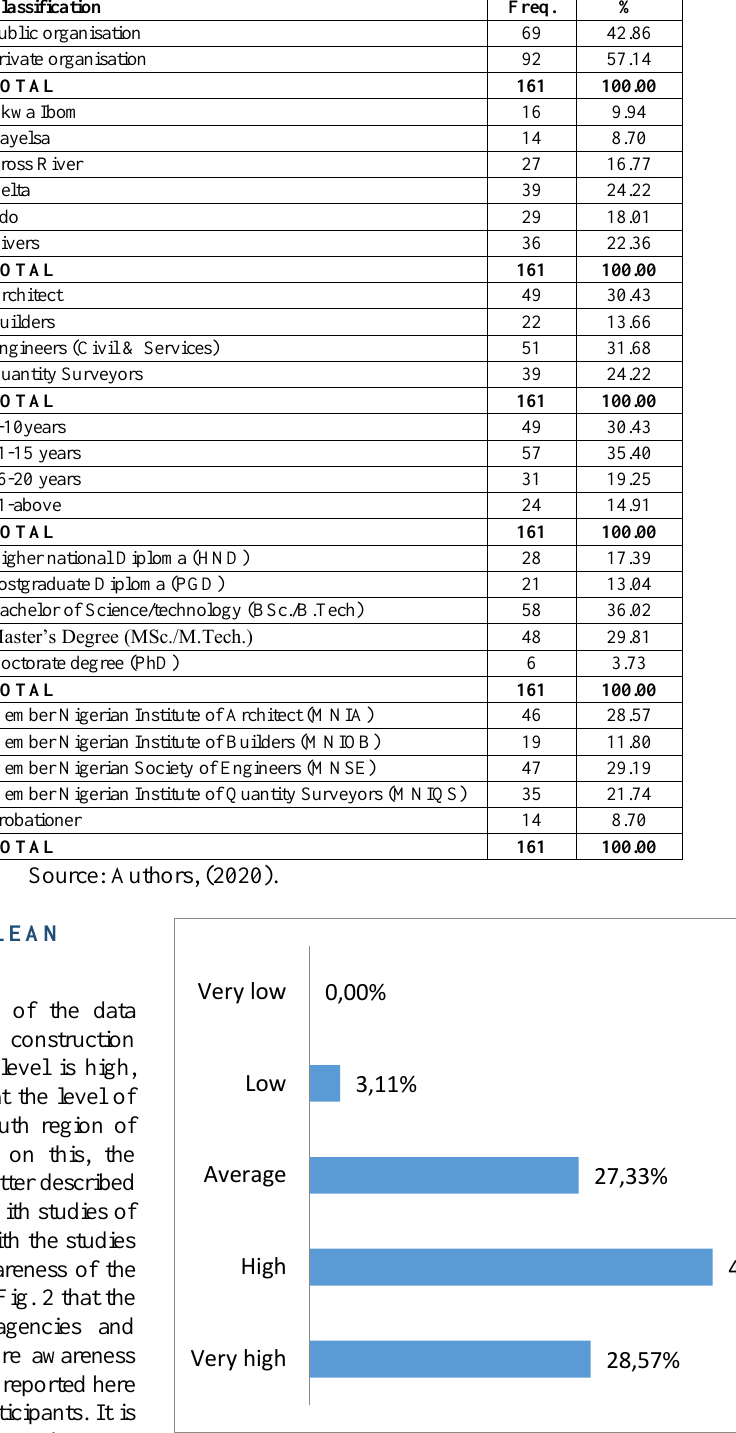
Figure 2: Level of awareness of the lean construction